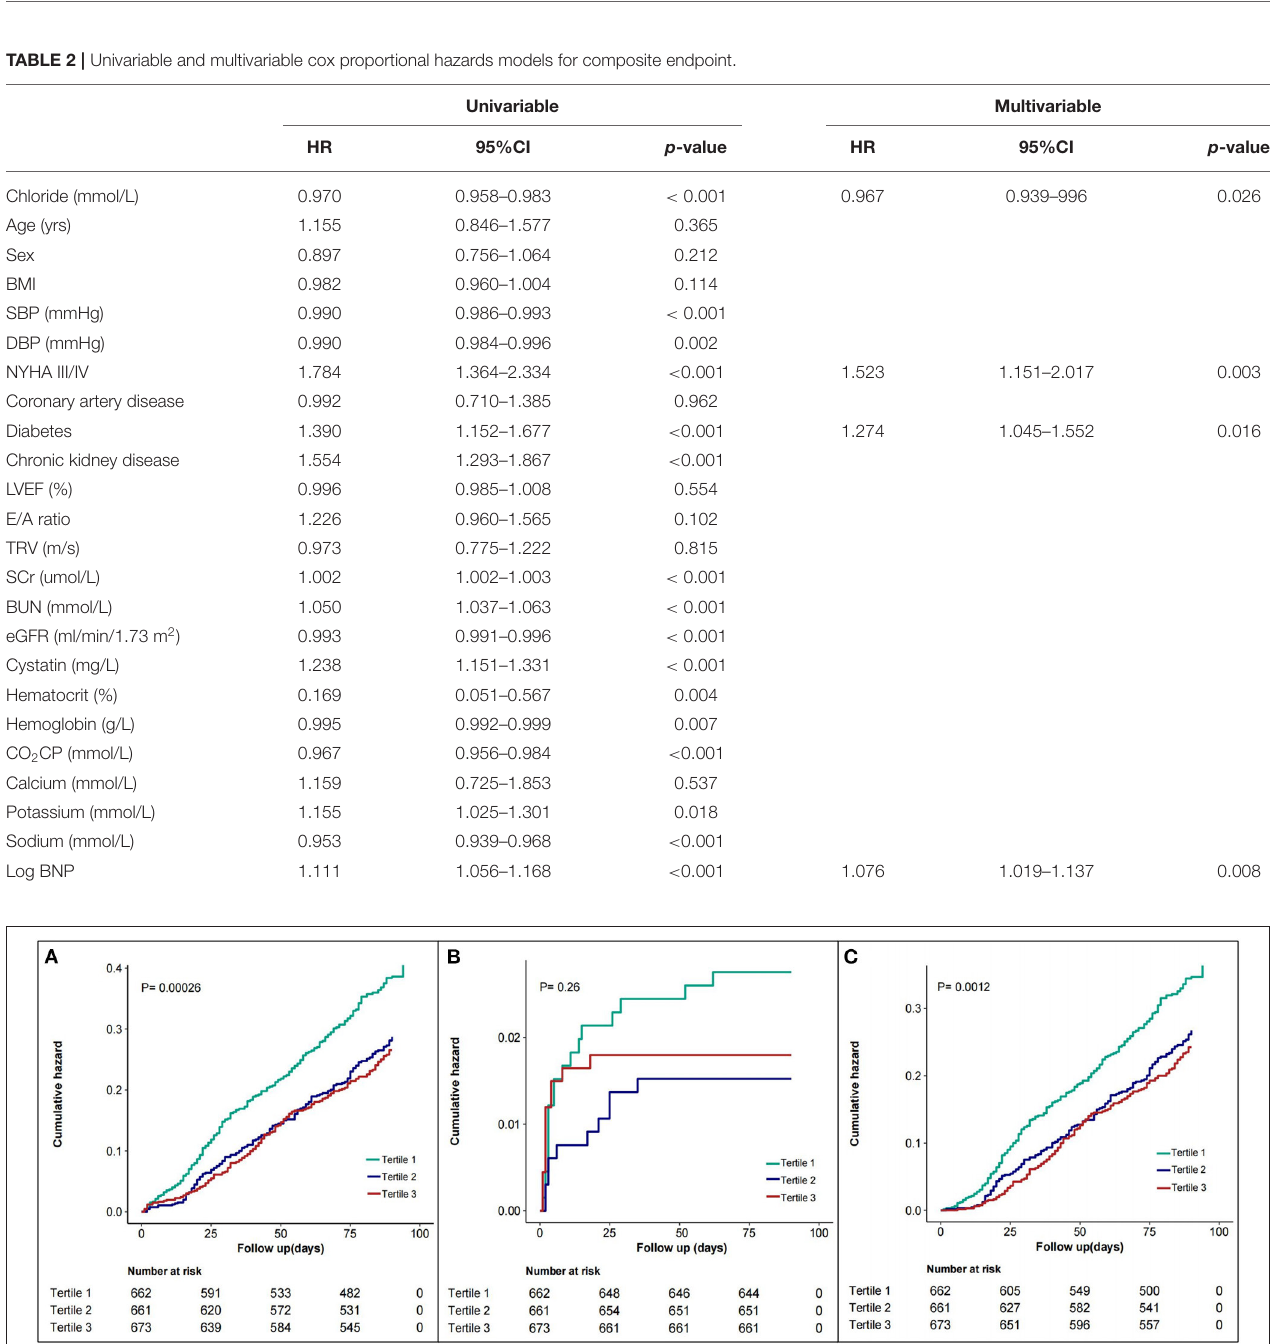
chronic heart failure has been dramatically improved. Out-of- hospital decongestion with oral diuretics has become